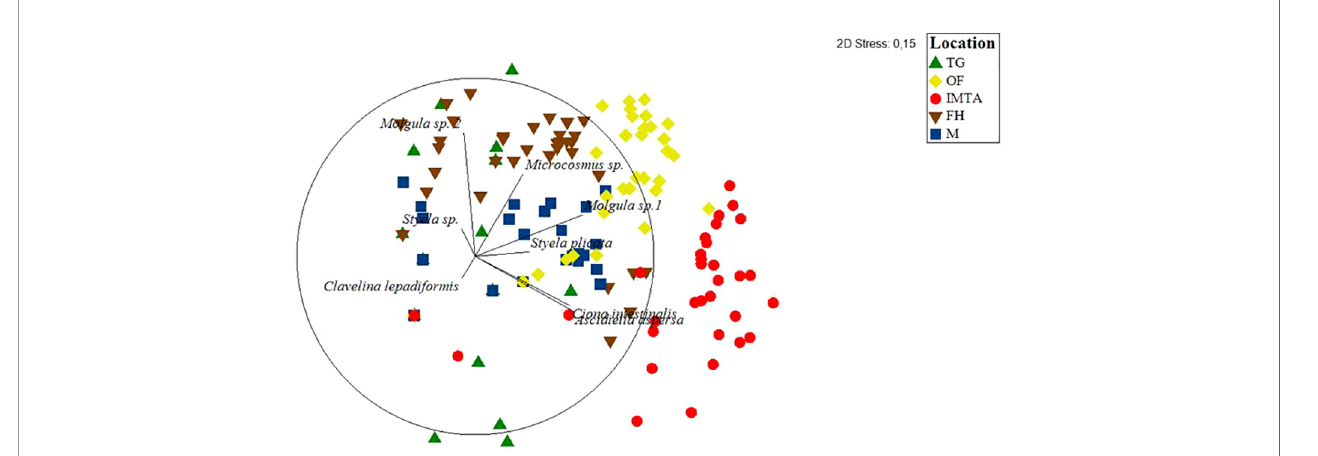
FIGURE 5 | Multidimensional scaling plot (MDS) with each dot representing the abundance values for each ascidian retrieved from each of the sampled locations and their spatial distribution. TG, Tide Gauge; FH, Fishing Harbour; M, Marina; OF, Oyster Farm; IMTA, Integrated Multi-Trophic Aquaculture.